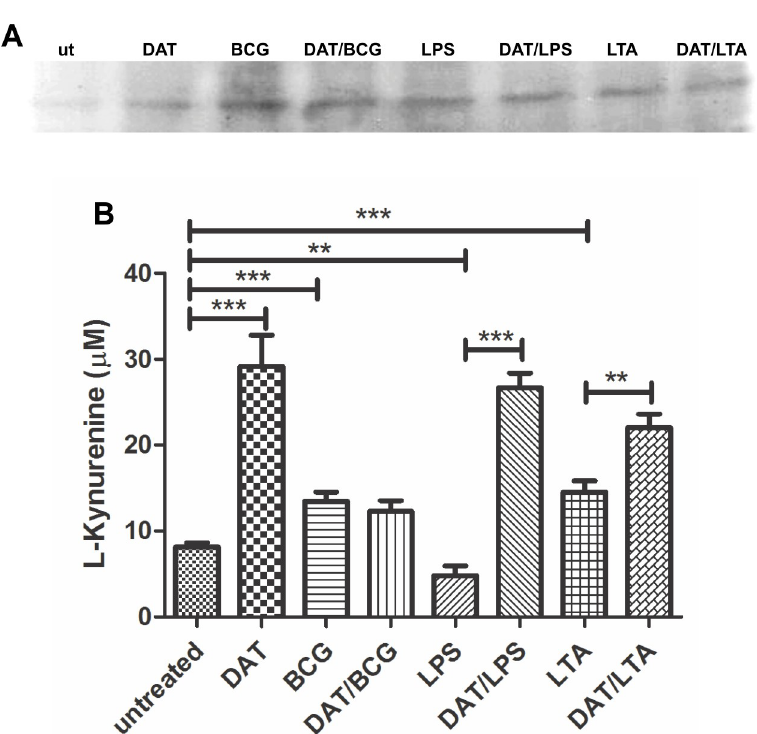
Fig 6. Di- O -acyl trehalose upregulates the expression of Indoleamine, 2,3 Dioxygenase in DCs activated with mycobacterial antigens and TLR agonists. IDO expression and enzymatic activity were analyzed by immunoblot and by measuring kynurenine production respectively. Immunoblot of DC proteins extracted with a RIPA buffer and separated in 12% PAGE-SDS gels demonstrates the expression of IDO under all experimental conditions, being in DCs activated with BCG most evident (A). In 2 h analysis DAT alone induced the highest levels (p = 0.0004; unpaired t Student’s test) followed by BCG and LTA (p = 0.0004 and p = 0.0003, respectively; unpaired t Student’s test). LPS failed to upregulate kynurenine, but in combination with DAT, a highly significant increase was demonstrated (p < 0.0001; unpaired t Student’s test); also, DAT potentiated LTA effects (p = 0.0121; unpaired t Student’s test) (B). The results shown were obtained in seven independent